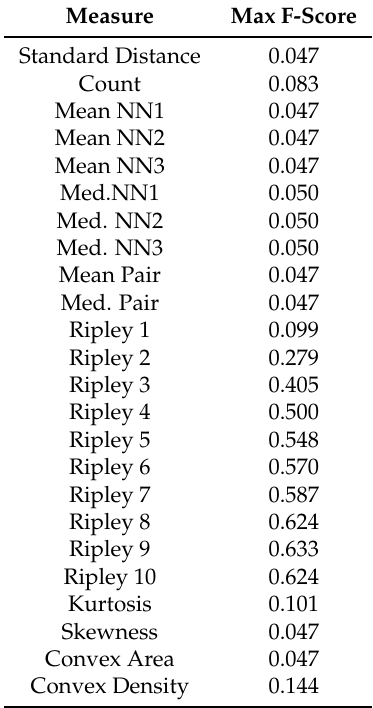
Table 3. Max F-scores for individual predictor variables trained and tested on data from Washington, DC.